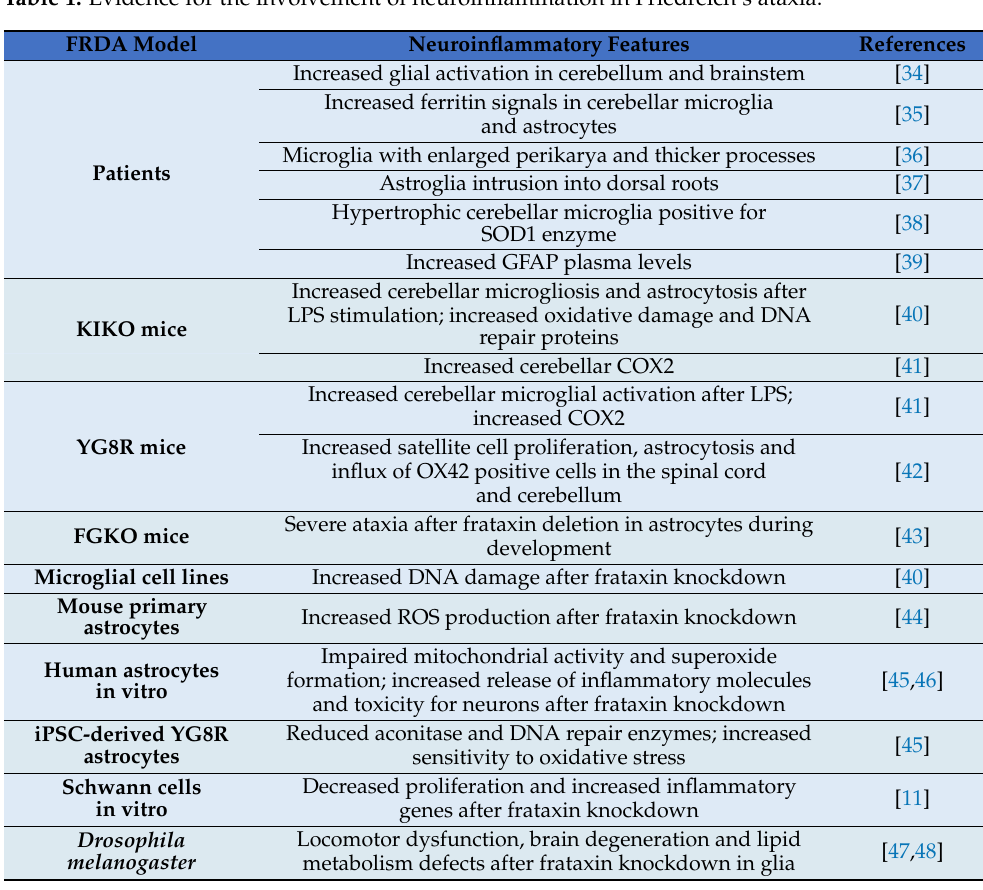
Table 1. Evidence for the involvement of neuroinflammation in Friedreich’s